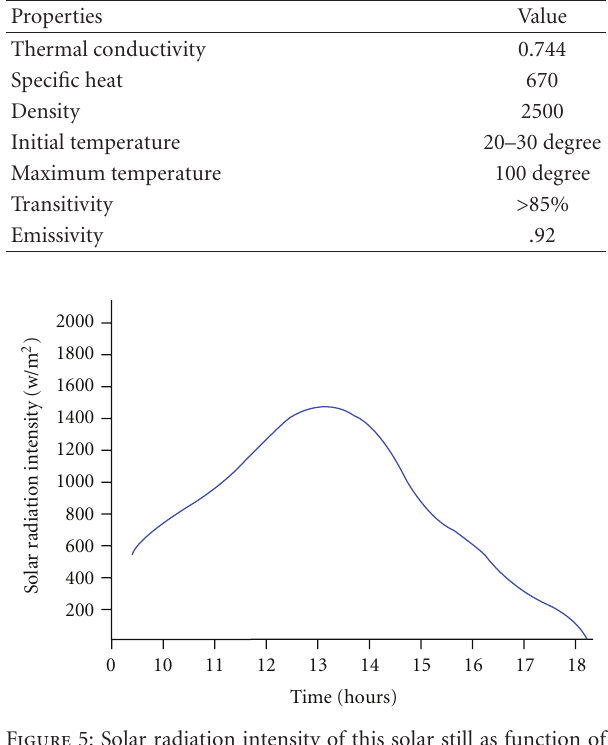
Figure 5: Solar radiation intensity of this solar still as function of time.